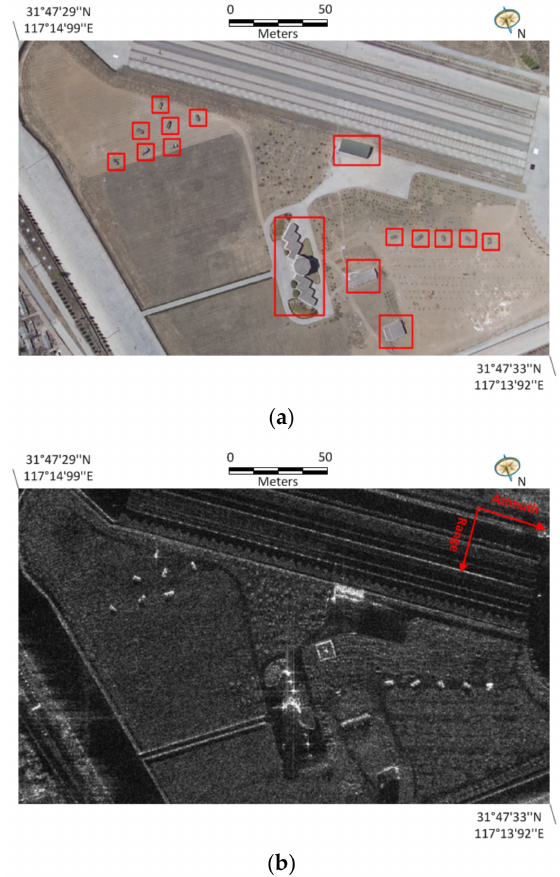
Figure 3. First study area and single-polarization SAR dataset with X-band. ( a ) Optical image from Google Earth. The red rectangles denote salient regions through human visual perception; ( b ) HH polarization SAR image with